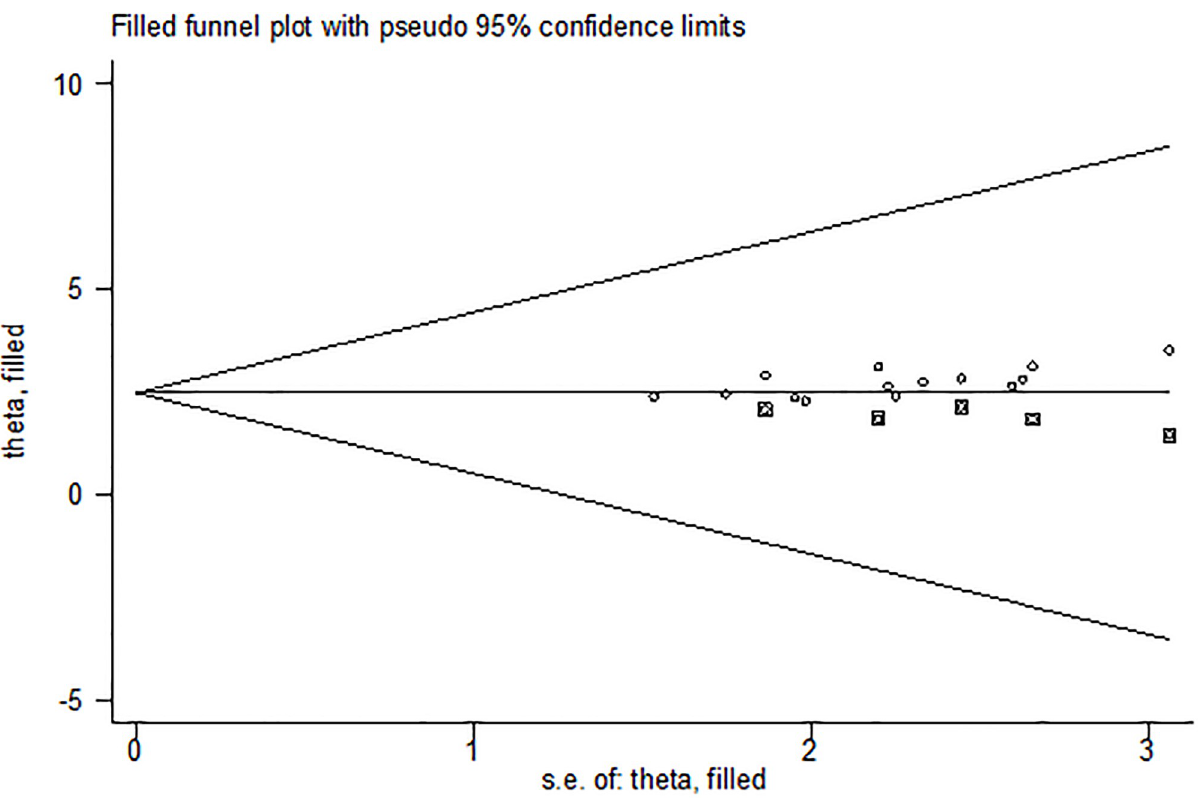
Fig 7. Counter enhanced funnel plot suggestions of missing studies on the bottom left-hand of the plot.